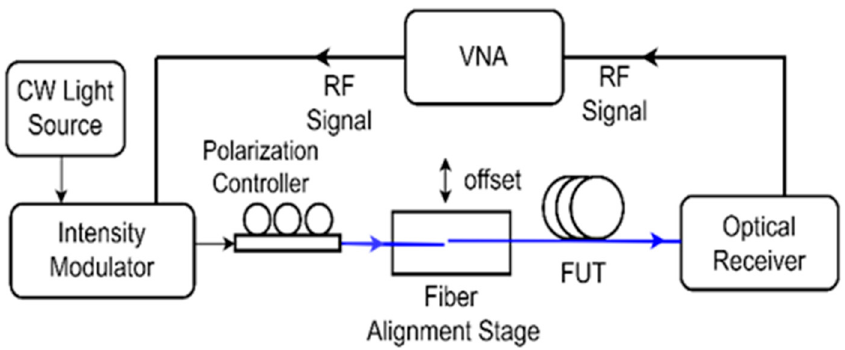
Figure 1. The schematic of the measurement setup.